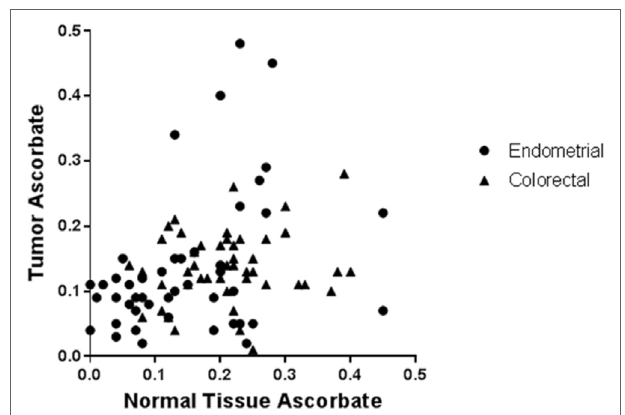
FiGURe 1 | Ascorbate levels in normal tissue are not associated with ascorbate levels in tumors from endometrial and colorectal cancer patients . Tissue samples from patients with endometrial ( n = 50) and colorectal cancer ( n = 50) were processed, and ascorbate levels (nanomoles per microgram DNA) were measured using HPLC-EC [data from Ref. (17, 18)]. From each patient, samples were obtained from tumor and adjacent normal tissue. There was no association between ascorbate content in tumor vs. normal tissue in individual patients with endometrial or colorectal cancer (Pearson correlation: R 2 = 0.001, p = 0.81, and R 2 = 0.022, p = 0.30, respectively). Hence, whole body ascorbate status may not predict tumor ascorbate